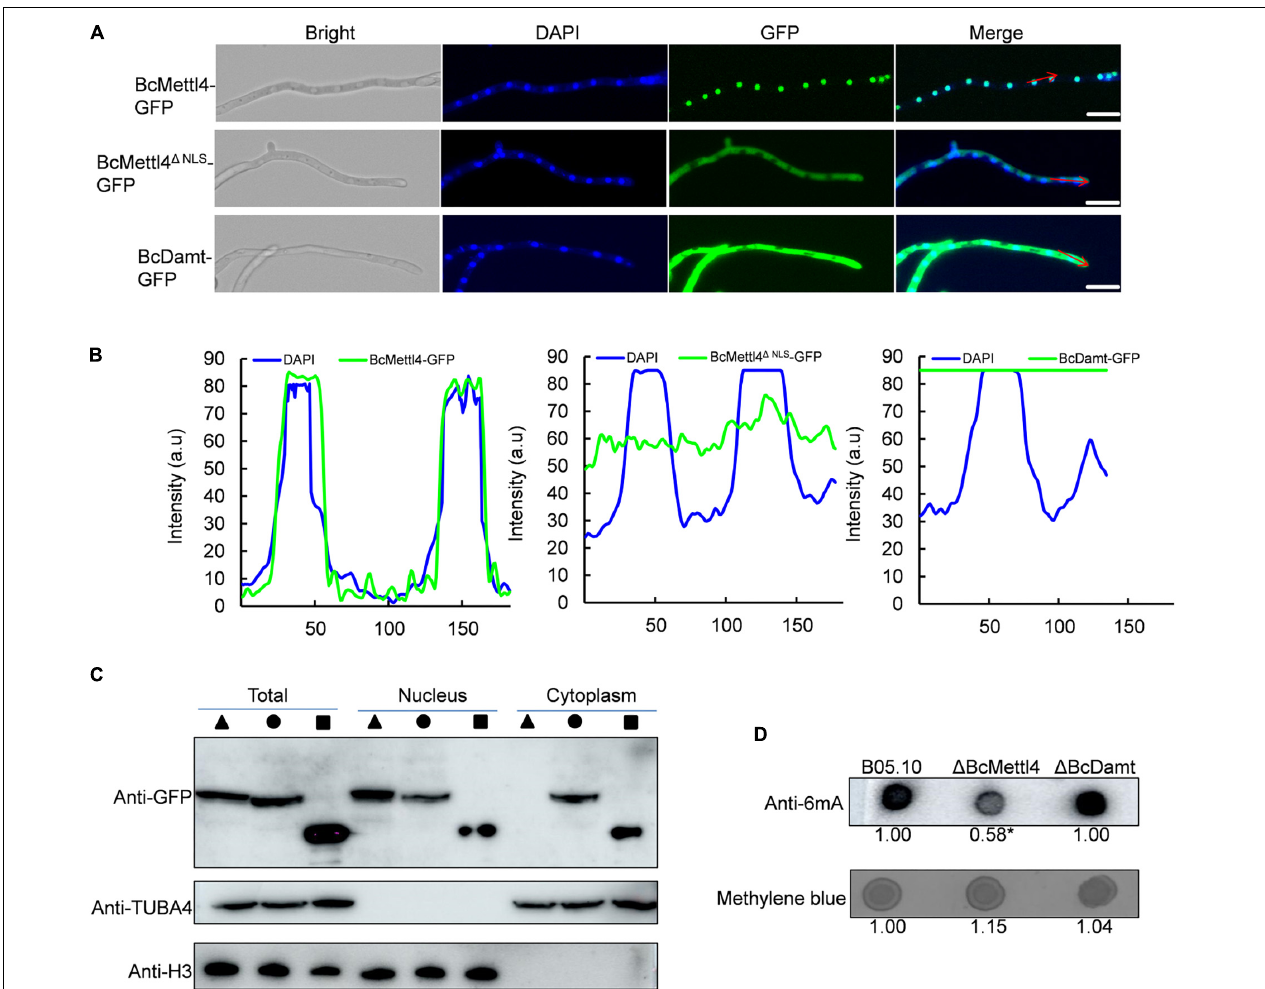
FIGURE 2 | Subcellular localization of BcMettl4 and BcDamt, and effects of BcMETTL4 and BcDAMT deletion on genome methylation. (A) Mycelia images for subcellular localization of the BcMettl4-GFP, BcMettl4 (cid:49) NLS -GFP, and BcDamt-GFP. Scale bar = 20 µ m. (B) Fluorescence intensity of BcMettl4-GFP, BcMettl4 (cid:49) NLS -GFP, and BcDamt-GFP. The blue line represents DAPI while the green line shows GFP. The signal areas were marked by red lines in Figure 2A and the signal quantification were calculated by ImageJ. (C) Western blot analysis of BcMettl4-GFP (triangle), BcMettl4 (cid:49) NLS -GFP (circle), and BcDamt-GFP (square). Histone H3 served as a reference for proteins in the nucleus. Alpha tubulin 4a was used as a control for cytoplasmic proteins. (D) Dot blot assay for verification the presence of 6mA in the genome DNA of B. cinerea . A total of 200 ng DNA was investigated by dot blot assay. Relative 6mA abundance in different strains was calculated by ImageJ. The relative ratio after normalization is to reflect the difference among various treatments. The asterisk means significant difference in values at p <